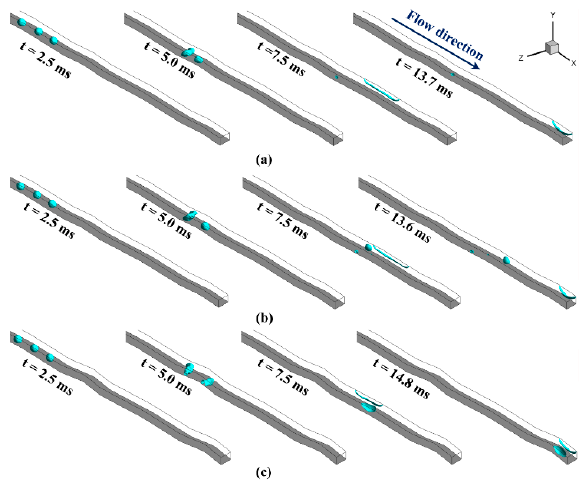
Figure 7. Temporal droplet flows in: ( a ) Design 1; ( b ) Design 2; and ( c ) Design 3 channels at an inlet velocity of 12.5 ms − 1 and contact angles θ GDL = 120 ◦ , θ side; top = 82 ◦ ; 82 ◦ velocity of 12.5 ms − 1 and contact angles θ GDL = 120°, θ side; top = 82°; 82° respectively.